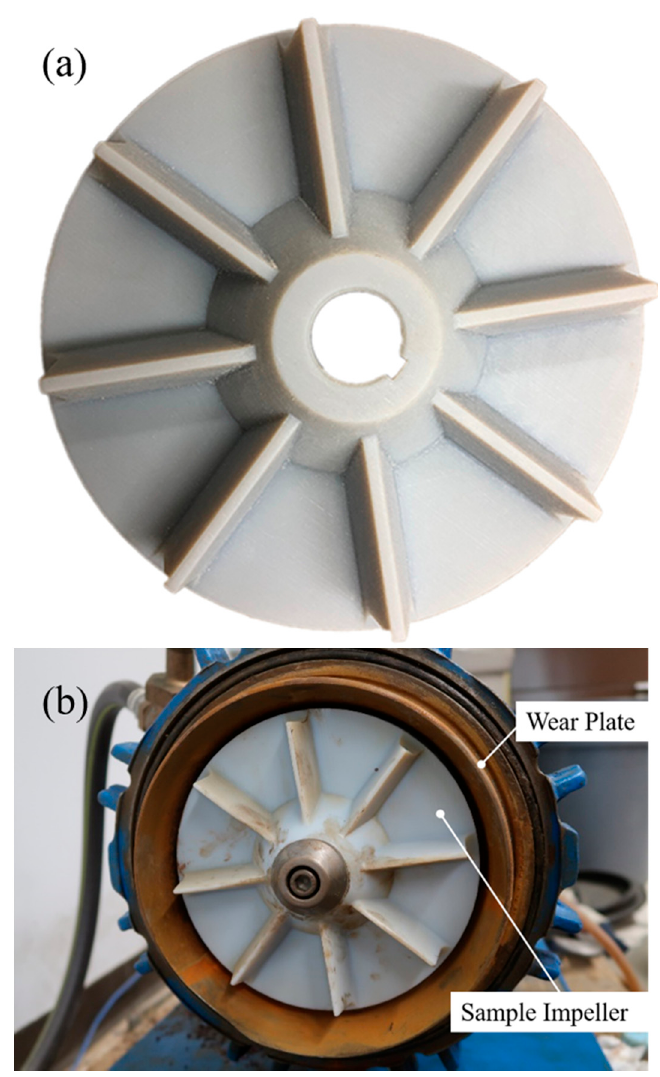
Figure 3. ( a ) VeroGray sample impeller, ( b ) Sample impeller on the